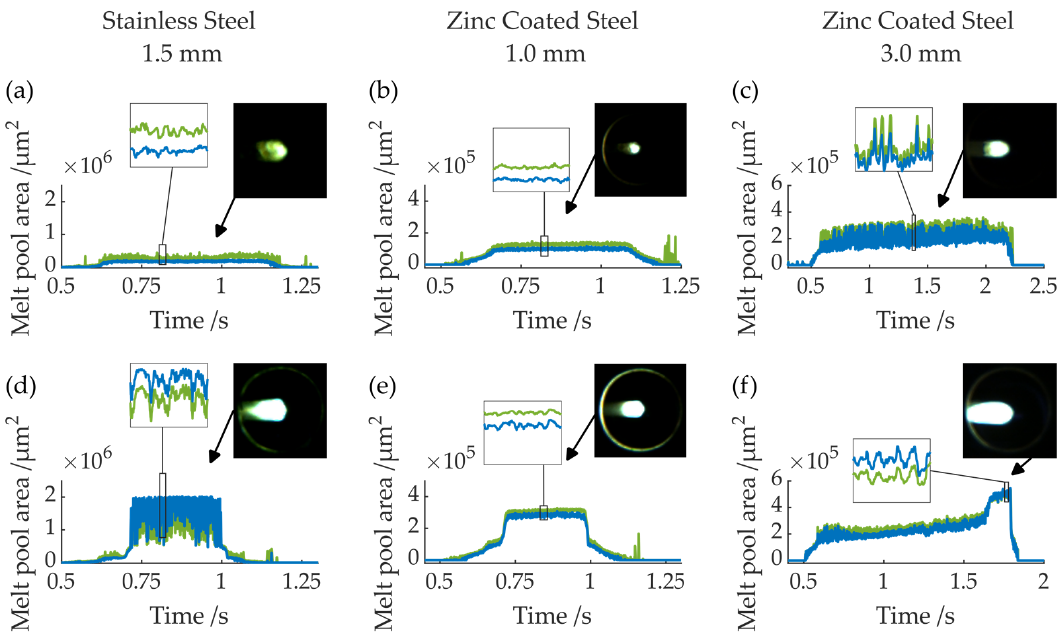
Figure 4. Signals for the green and blue channels of complete cuts ( a – c ) and incomplete cuts ( d – f ) and an example image of the corresponding signal highlighted by black arrows for stainless steel with a sheet thickness of 1.5 mm and zinc-coated steel with a sheet thickness of 1.0 and 3.0 mm.